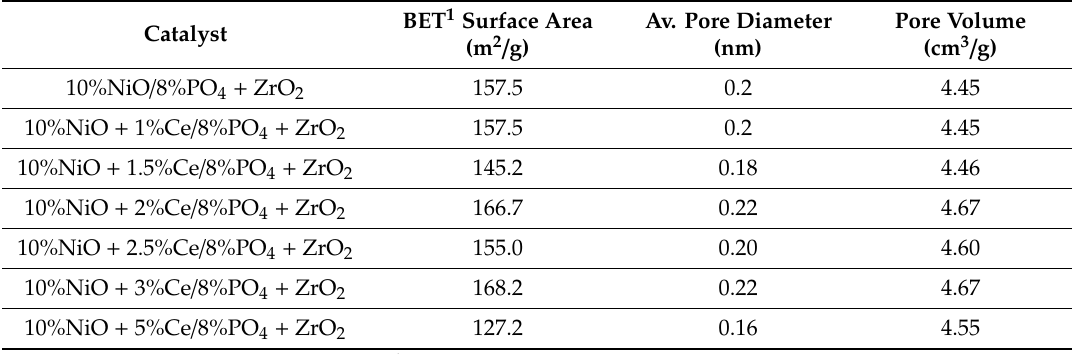
Table 1. Textural properties of 10% Ni catalysts supported by 8%PO 4 and ZrO 2 and promoted by di ff erent amounts of cerium.